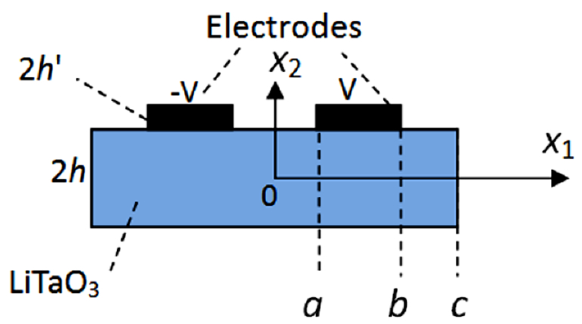
Figure 1. A LiTaO 3 crystal plate with lateral field excitation.